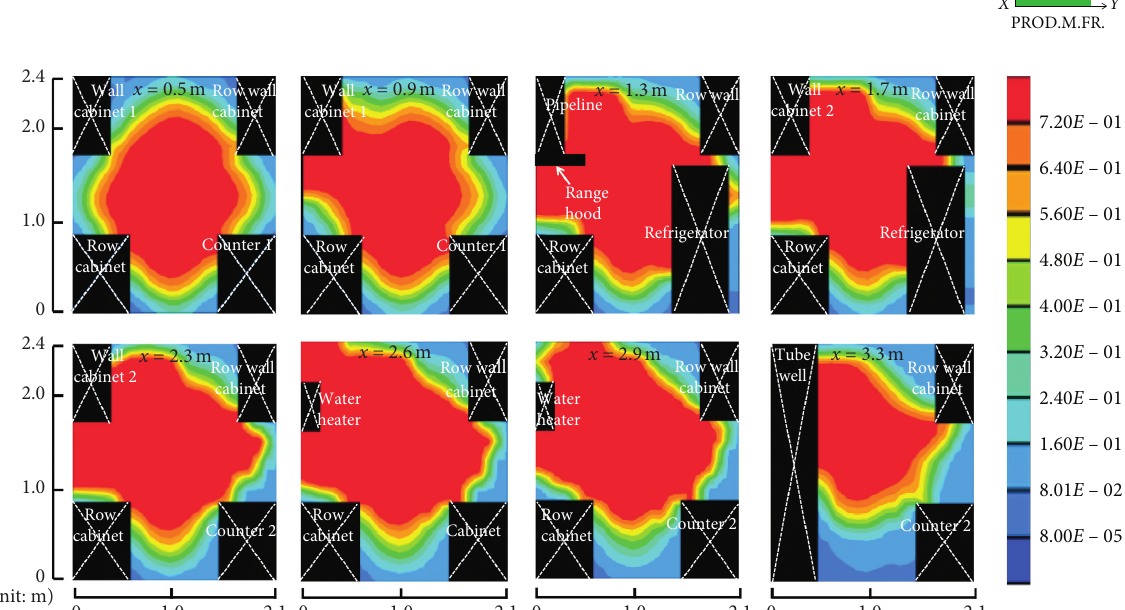
Figure 9: The reaction change process of different cross sections at t � 374ms (the number on each cloud diagram is the distance to the back wall; PROD.M.FR is the mass fraction of combustion products).